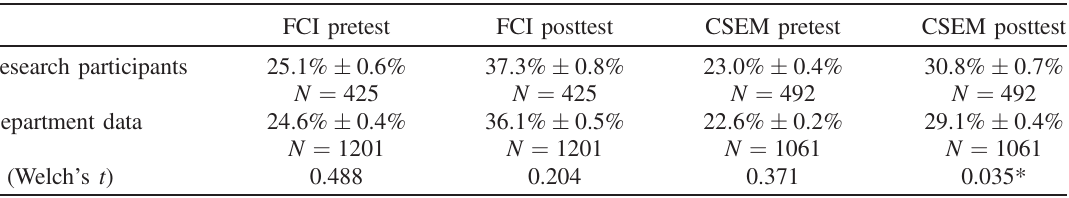
TABLE VIII. The average scores with standard errors on concept inventories from research participants and department data. The p value from a Welch ’ s t test is also shown. * p < 0 . 05